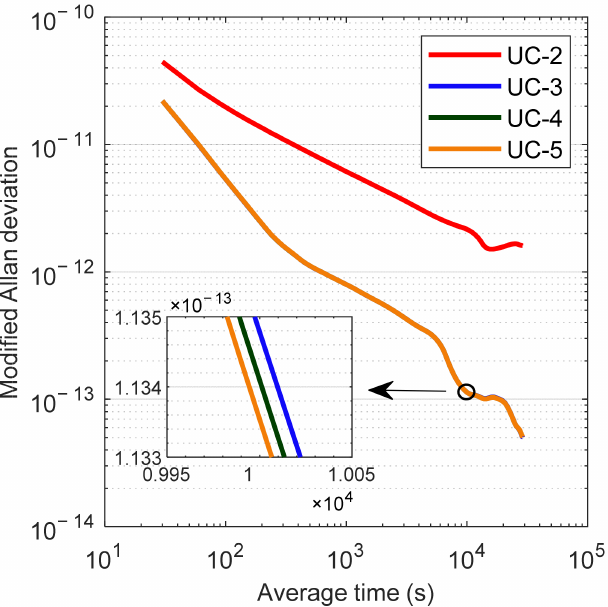
Figure 18. MDEV of the time link BRUX-MRC1 derived from Galileo dual-, triple-, four-, and five-frequency UC PPP on DOY 249,